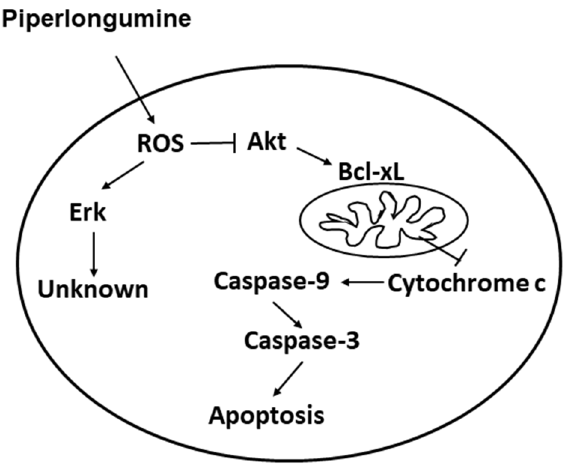
Figure 9. Illustration of the mechanisms involved in piperlongumine-mediated cellular apoptosis. Cell proliferation and cell survival are modulated with an intricate network, such as signaling pathways; controlling one or two factors of them may not be enough to manage malignant growth. Because of the increased metabolism in malignant cells, ROS accumulation is common, and can be used as a therapeutic target for malignant cells. In the present study, we demonstrated that PL successfully induces ROS overexpression in TC cells to interfere with cell survival mechanisms and achieve apoptosis induction.